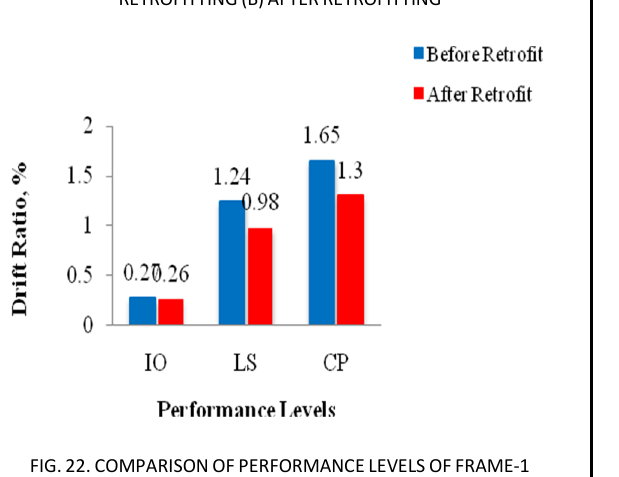
FIG. 21. PERFORMANCE LEVELS OF FRAME-1 (A) BEFORE RETROFITTING (B) AFTER RETROFITTING